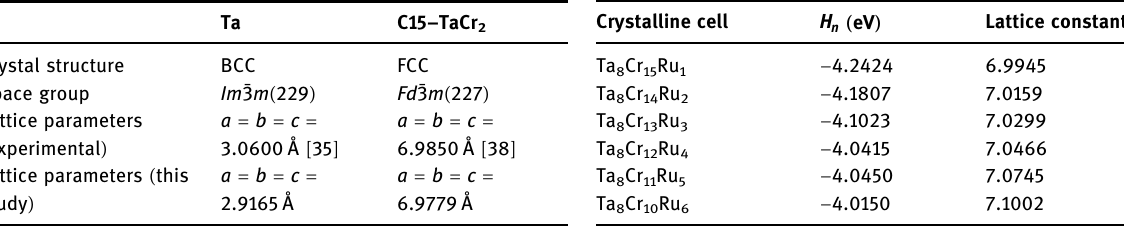
Table 3: Formation enthalpy H n and lattice constants of Ta 8 Cr 16 − n Ru